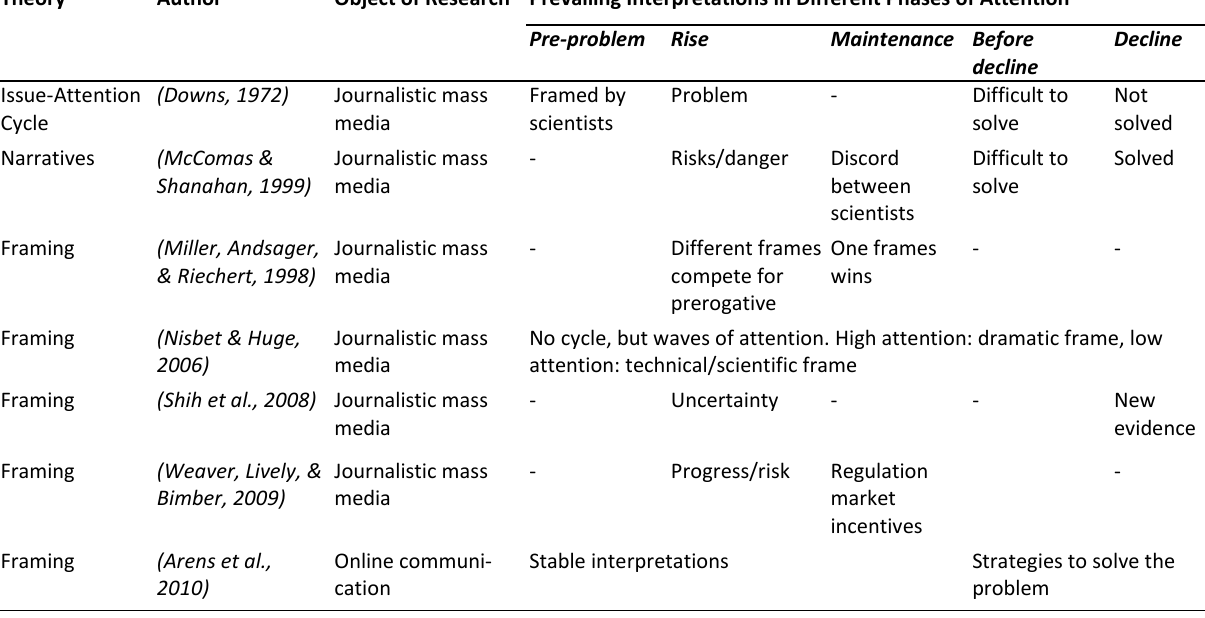
Table 1. Research overview on dynamics of sub-topics and interpretations.